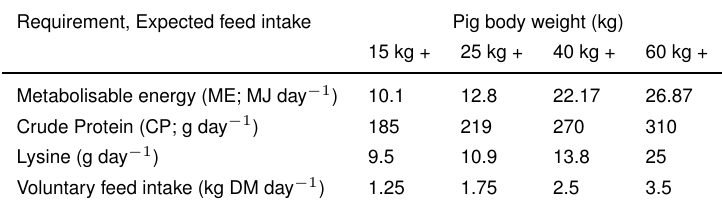
Table 3. Nutritional requirements and expected feed intakes of pigs